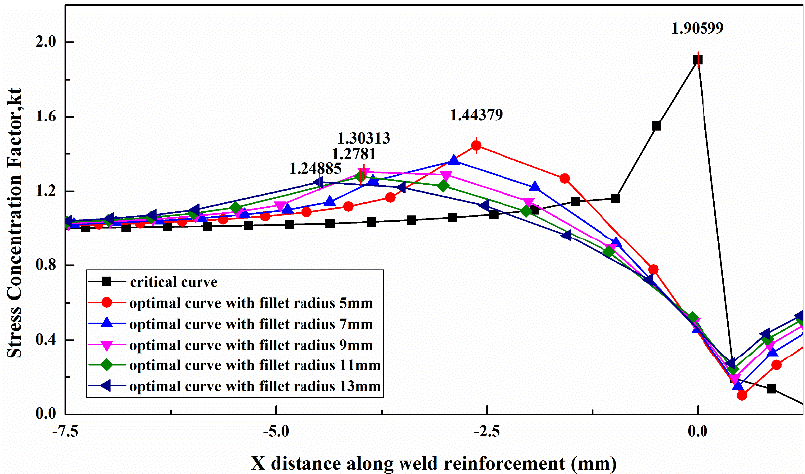
Figure 10. Simulation results of the variation of the stress concentration factor distribution with the transition arc radius r 1 .